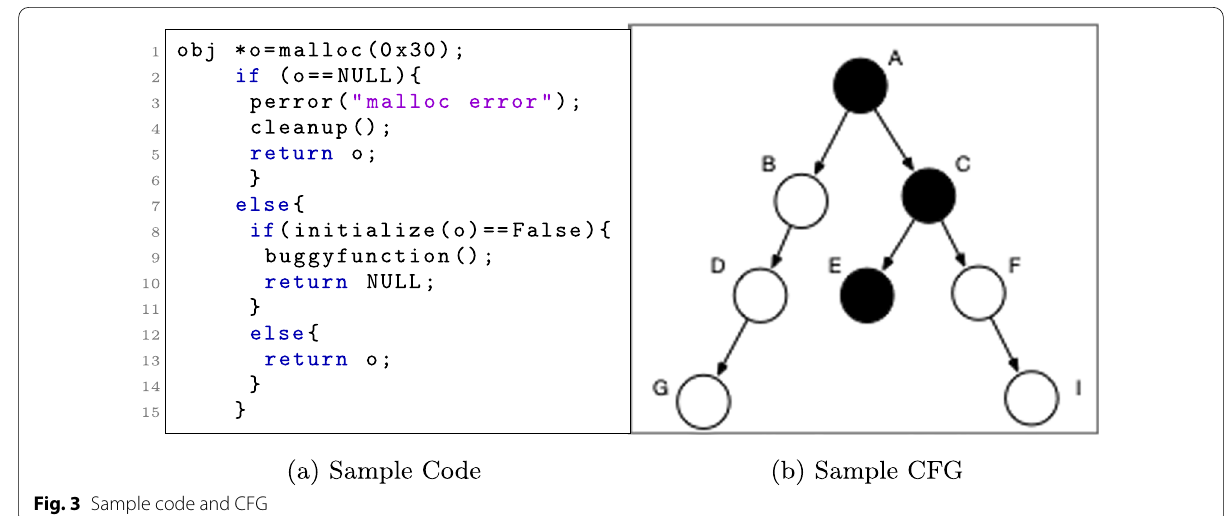
Fig. 3 Sample code and